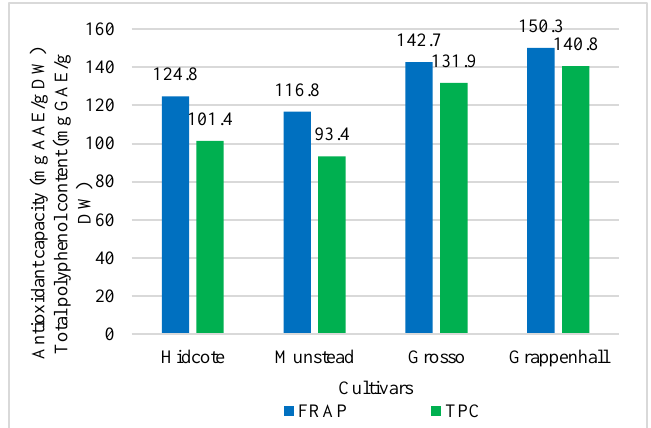
Table 4. Correlation between the antioxidant capacity (FRAP) and total Figure 2. Antioxidant capacity (FRAP: mg AAE/g DW) and total polyphenol polyphenol content (TPC) values of cultivars involved in different growing content (TPC: mg GAE/g DW) values of L. angustifolia and L. × intermedia cultivars in Szomód (2017).